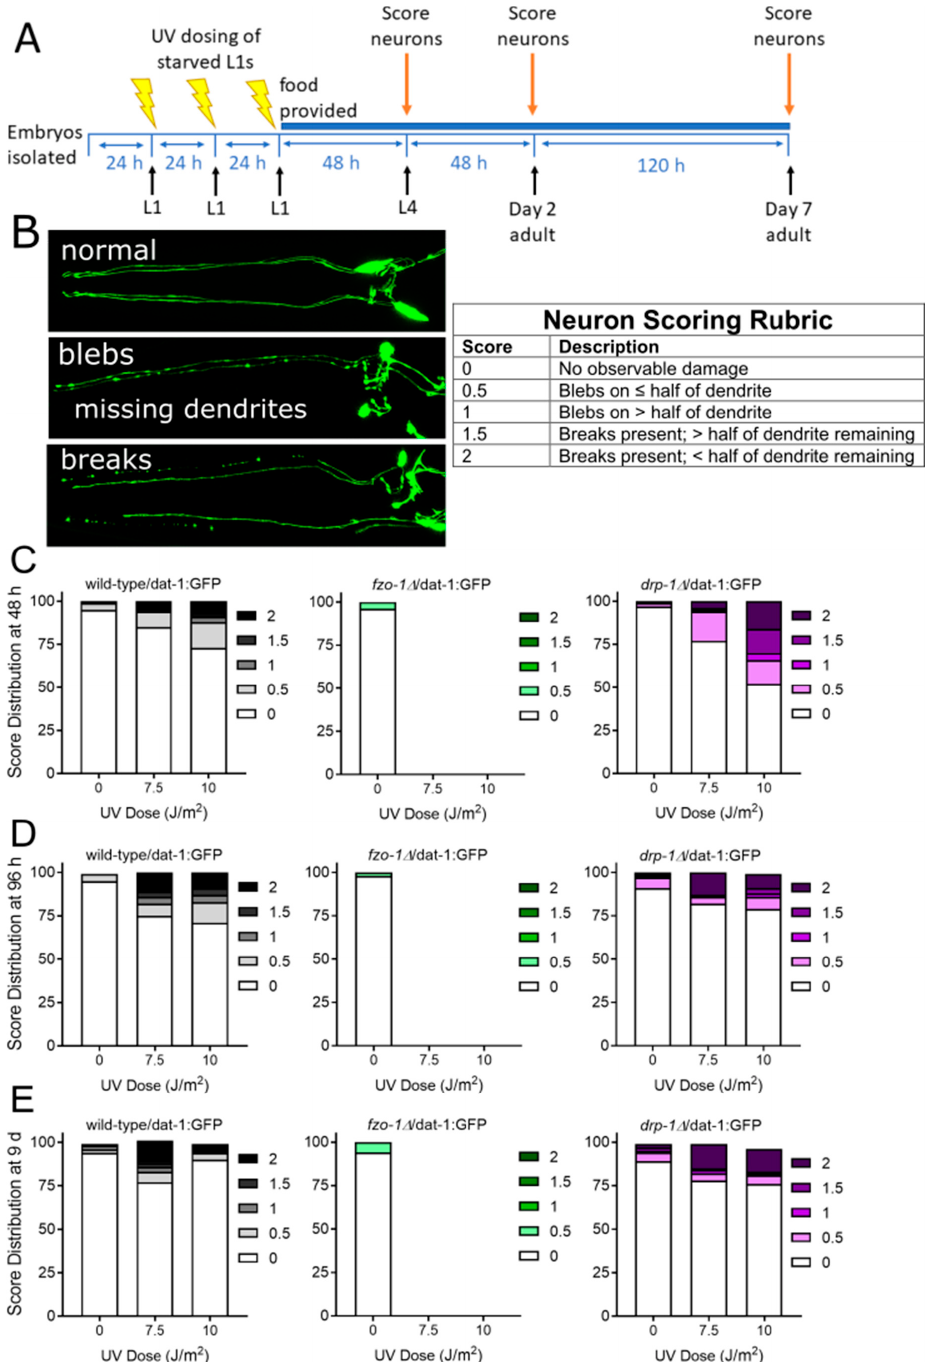
Figure 2. Genetic deficiencies in mitochondrial fusion cause UVC-induced L1 arrest and lethality in fusion-deficient fzo-1 Δ worms, and fission-deficient drp-1 Δ worms are sensitized to UVC-induced neurodegeneration. For experiments, synchronized L1 larvae were exposed to UVC radiation on three consecutive days and then provided with food and allowed to develop (Panel A ). Neurodegeneration (as shown in Panel B ) was then measured 48 h (Panel C ), 96 h (Panel D ), and 9 days (Panel E ) following exposure. Scoring, as shown in Panel B, was performed as described in Methods: 0 represents no degeneration, while increasing numbers represent increasing severity of degeneration. Data shown are combined from three biological replicates with each treatment group comprising n > 40 worms scored for dendrites on each of 4 cephalic neurons for a total of > 120 dendrites